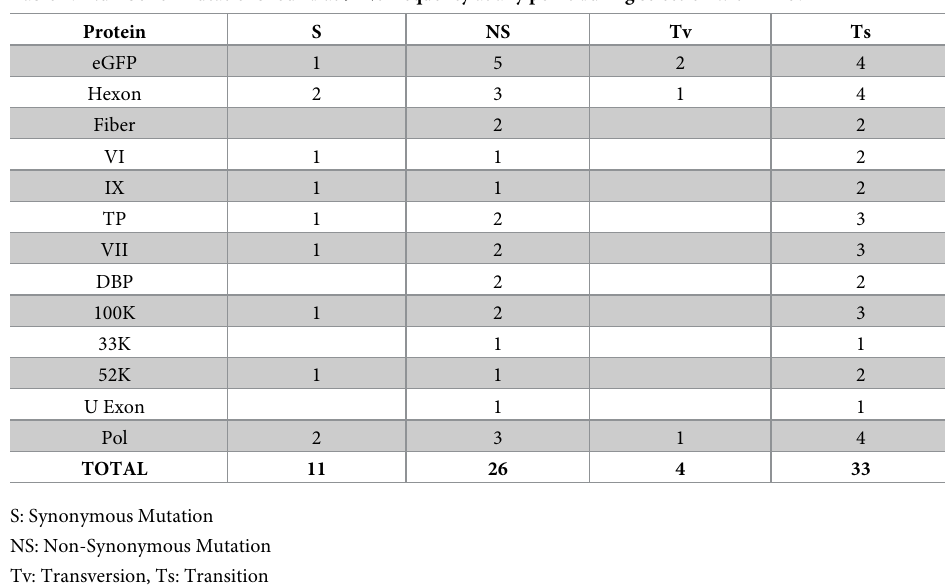
Fig 1. Selection of HD5-resistant HAdV-5. HAdV-5 “mutator” virus was pre-bound to 293 β 5 cells and then incubated with HD5 to select for resistant viruses. (A) The right y-axis indicates the concentration of HD5 used for selection (solid black line). The left y-axis indicates the percentage of reads containing the denoted mutations in hexon (blue) and L4-100K (purple) in pools of virus expanded from the bulk selected population. (B) All mutations in other proteins that were found in at least 50% of the population during selection. (C) HD5 IC 50 s of pools of virus expanded from the bulk selected population were determined on 293 β 5 cells. Each point is an independent experiment, and linear regression with 95% confidence bands is graphed.